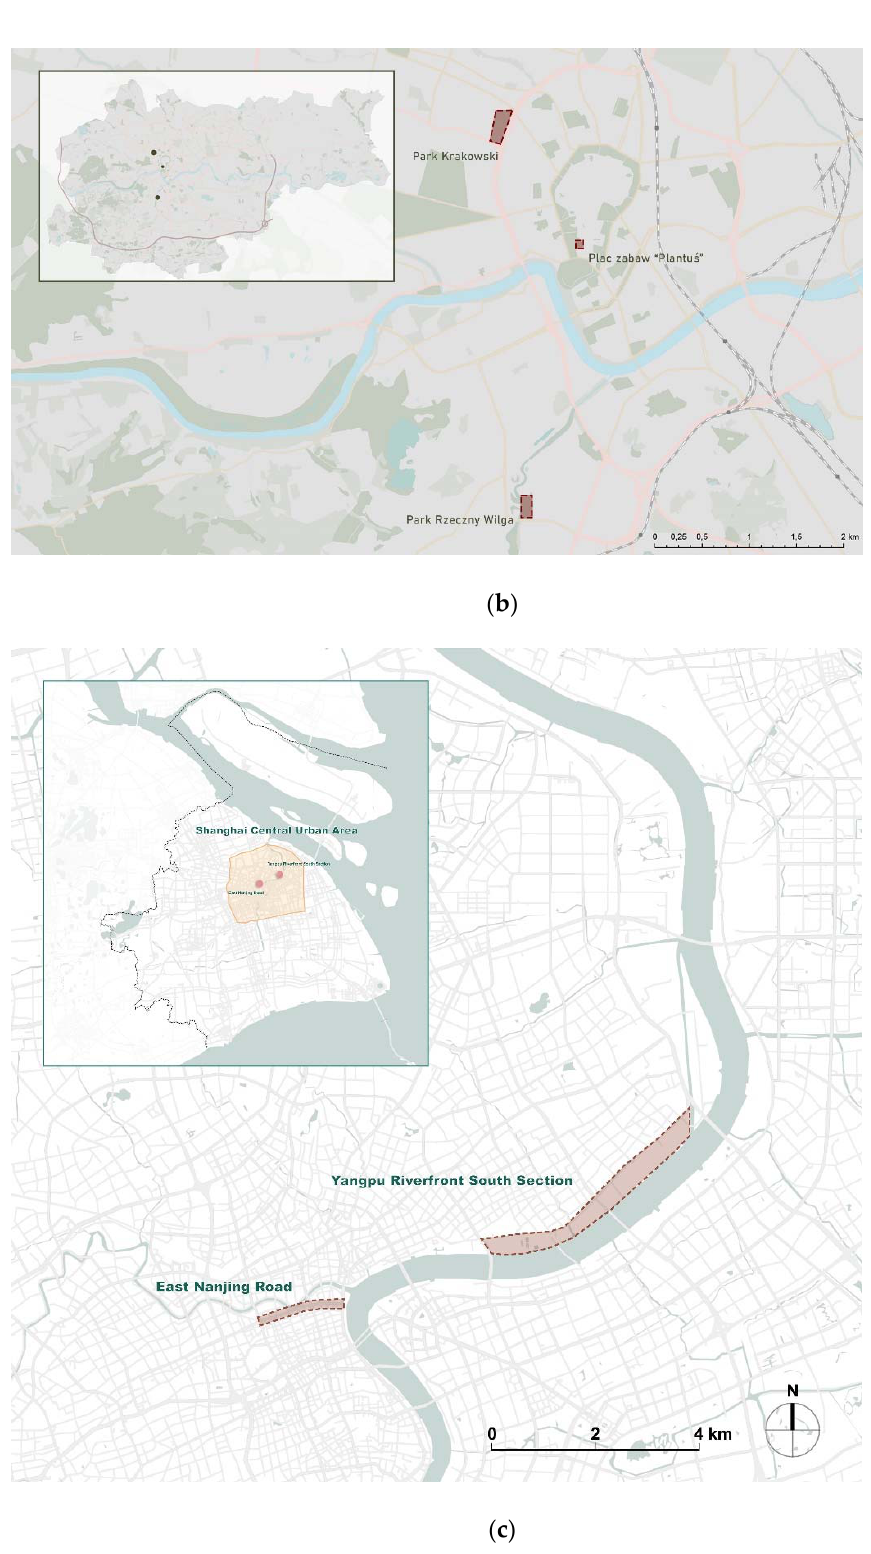
Figure 1. ( a ) The location of case studies from Budapest, Hungary. ( b ) The location of case studies from Kraków, Poland. ( c ) The location of case studies from Shanghai, China (prepared by the authors) .